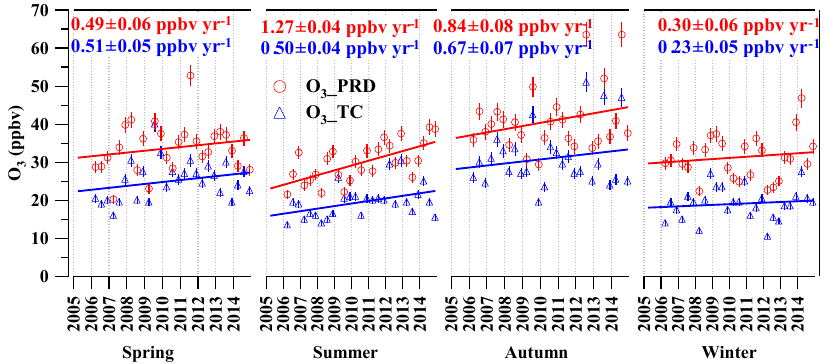
Figure 5. Trends of observed O 3 in inland PRD (red line) and at TC (blue line) in four seasons during the period 2006–2014. Each data point in the figure is obtained by averaging hourly values into a monthly value. Note: due to the location of sites which might have O 3 transport to TC (Guo et al., 2009), three regional background sites (i.e. Wanqingsha, Jinguowan, and Tianhu) and an urban site (i.e. Haogang) in Dongguan are used for comparison. Error bars represent 95% confidence interval of monthly